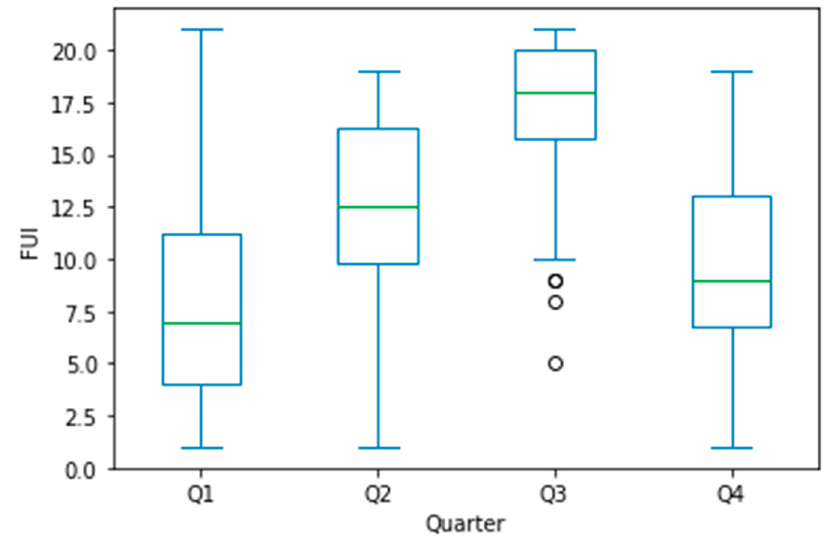
Figure 8. Quarterly FUI variations across five years.